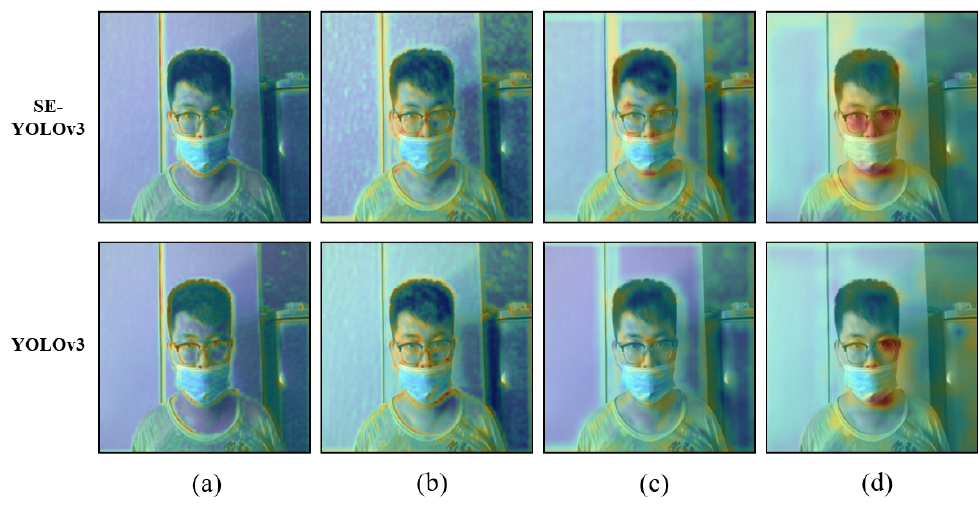
Figure 6. The visualization of the feature map for SE-YOLOv3 and YOLOv3. Columns ( a – d ) are from the convolutional network in C1, C2, C4, and C5 (mentioned in Figure 2), respectively.